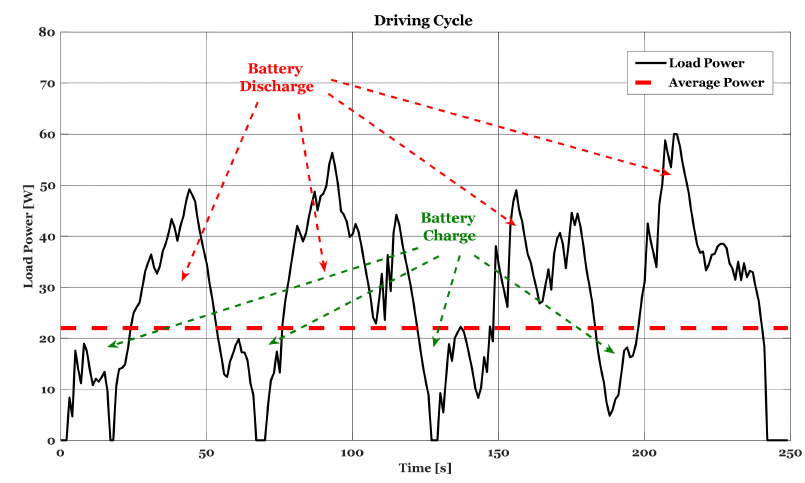
Figure 13. Typical vehicle driving cycle